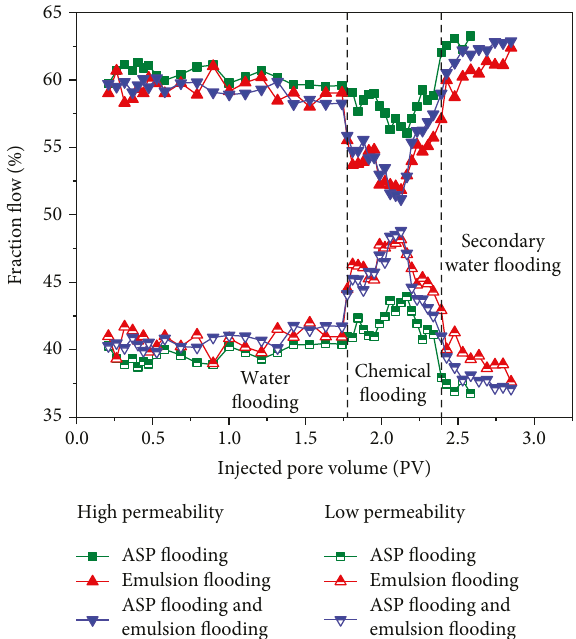
Figure 8: Fractional fl ow of each layer variation curve of di ff erent chemical fl